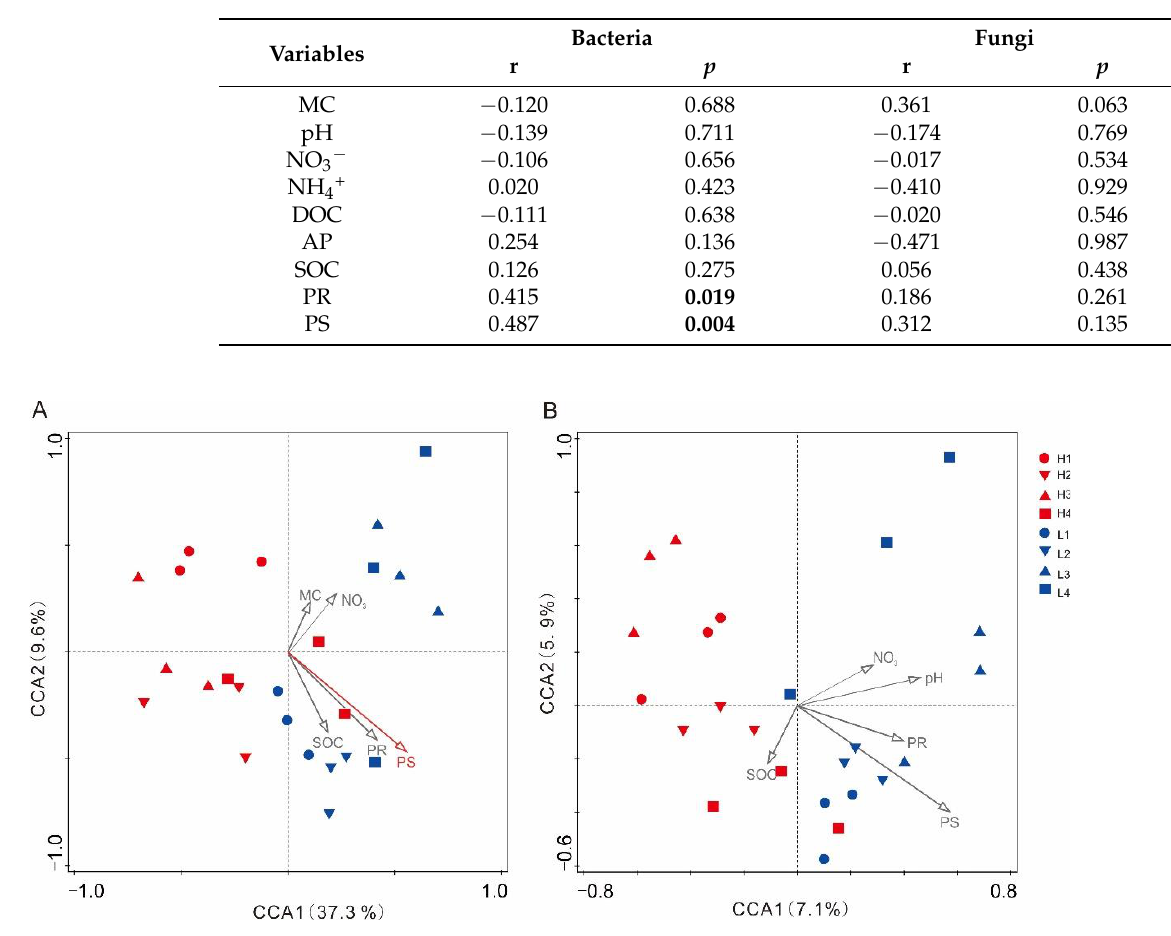
Figure 4. Canonical correlation analysis (CCA) of soil microbial communities of the forests across elevations on Wuyi Mountain (n = 24). ( A ) Bacteria and ( B ) fungi.